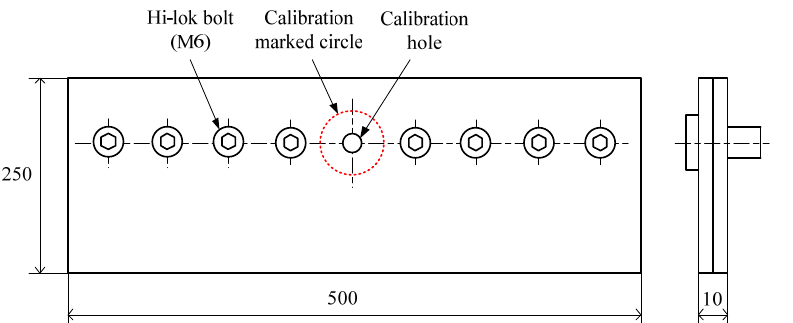
Figure 13. Test specimen (unit: mm).